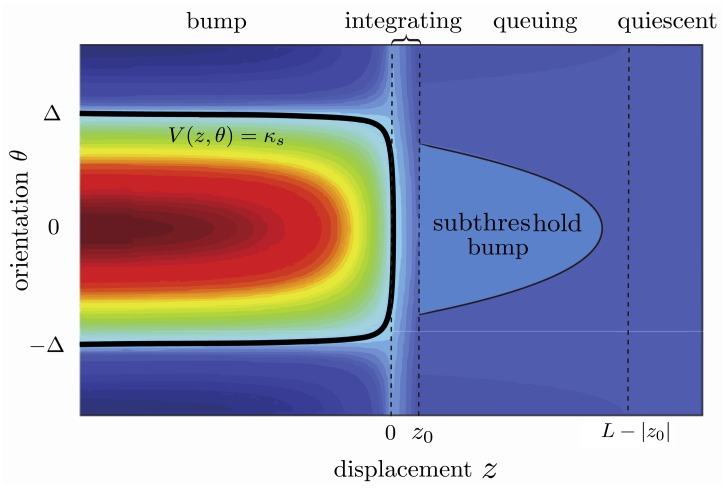
Graphical construction of a traveling wave solution.The four regions quiescent, queuing, integrating, bump are superimposed on a traveling wave solution of the neural field Eq (12). Here L denotes the range of long-range connections and z
0, z
0 < 0 is the point at which activity in the superficial layer first reaches threshold. (The location of the front in the deep layer is at z = 0.) In the quiescent region (z > L − ∣z
0∣) there is no activity. In the queuing region (0 < z < L − ∣z
0∣) neural populations have not received input from the deep layer, but receive a weak orientation-dependent input from the active region via the horizontal connections. This leads to the formation of sub-threshold orientation bumps, which grow in the integrating region (z
0 < z < 0) where populations now also receive orientation-independent input from the deep layer. Finally, the growing bumps cross threshold in the bump region (z < z
0) evolving to a bump of half-width Δ as z → −∞. (We use a different color code than Figs 6 and 7 in order to highlight the different regions. Here red indicates high activity and blue low activity.)